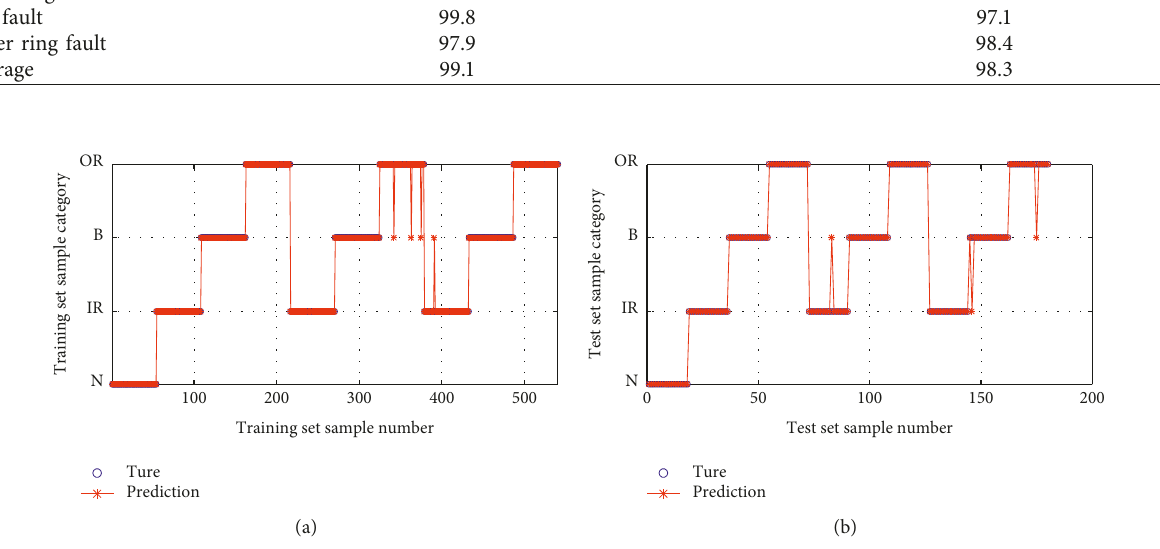
Figure 13: Fault diagnosis of a certain experiment. (a) Results of NKH-KELM with classification accuracy � 99.2593%. (b) Results of NKH- KELM with classification accuracy �